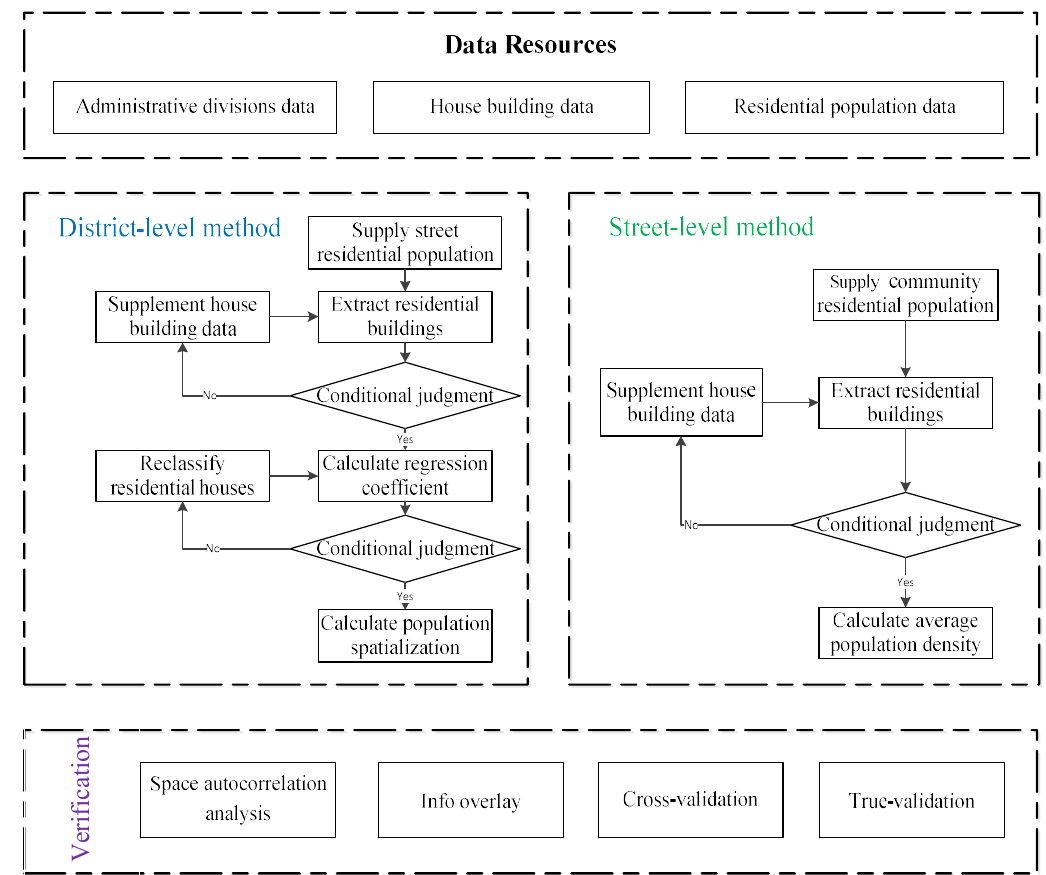
Figure 2. Workflow of Multi-level Population Spatialization Method and Verification.